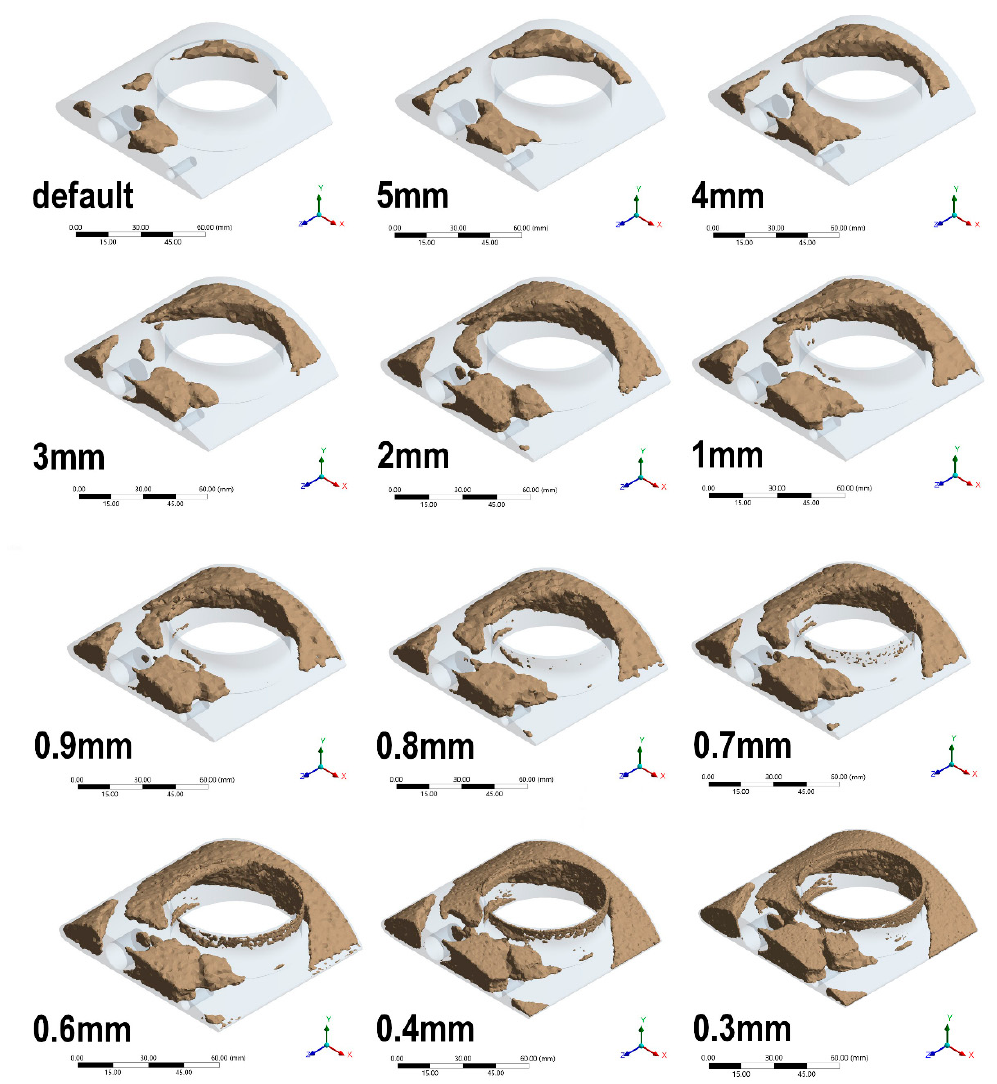
Figure 14. Topology optimization results with different global mesh sizes.